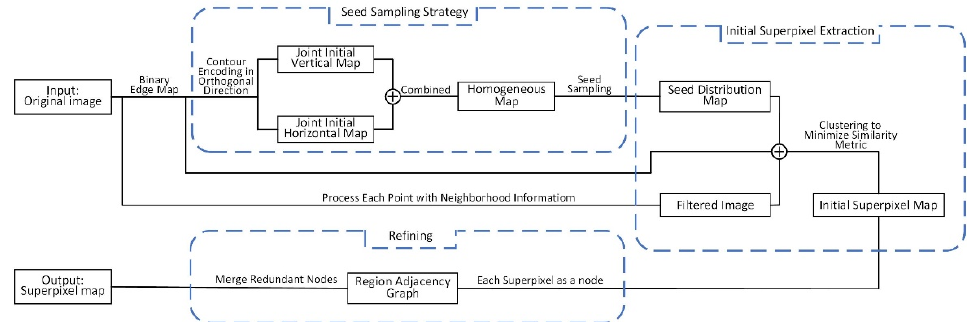
Figure 1. Block diagram of the proposed